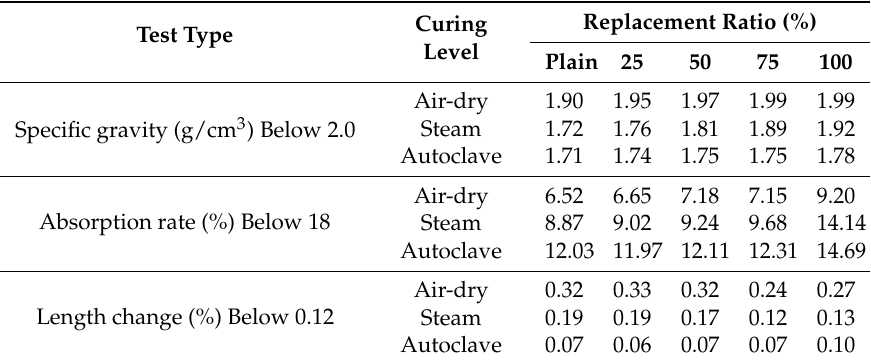
Table 5. Specific gravity, absorption ratio and length